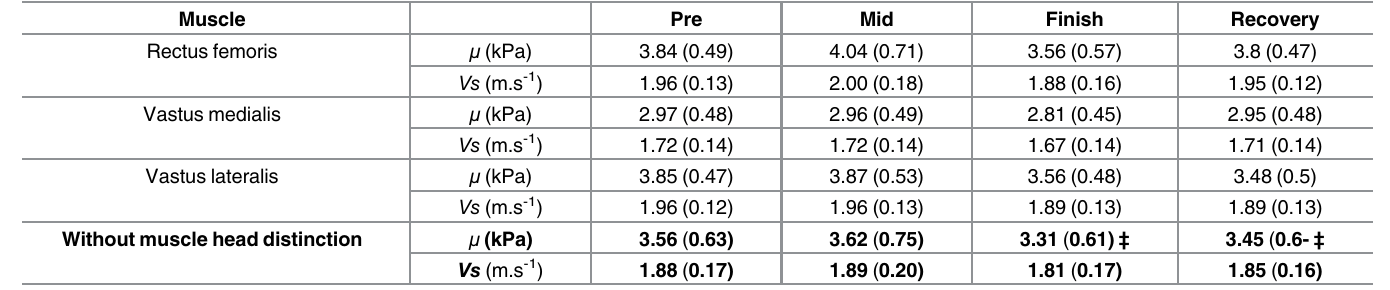
Table 3. Longitudinal shear modulus ( μ ) and shear wave velocity ( Vs ) variations over time.